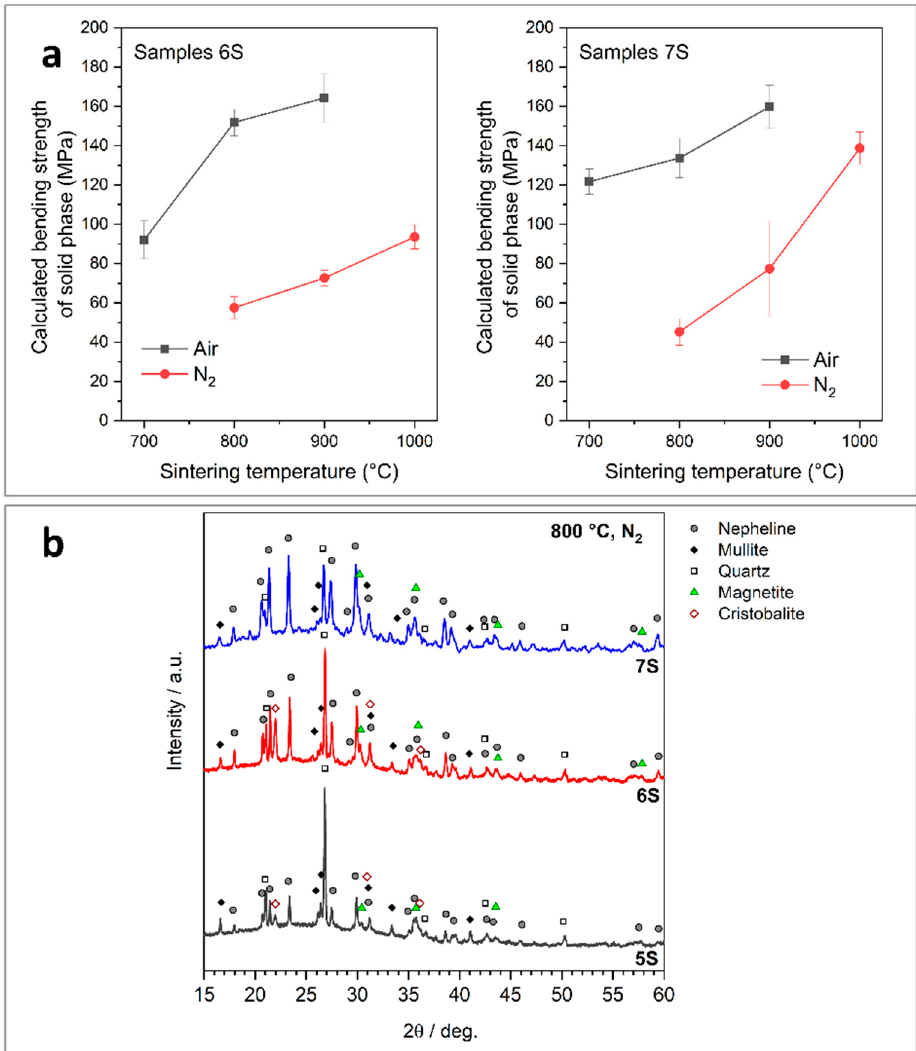
Figure 3. ( a ) Comparison of calculated bending strength of 6S and 7S samples fired in air [15] and in N 2 ; ( b ) evolution of phase assemblage, after firing at 800 °C (in N 2 ) according to reduction of the fly ash from coal combustion (FA)/glass ratio.